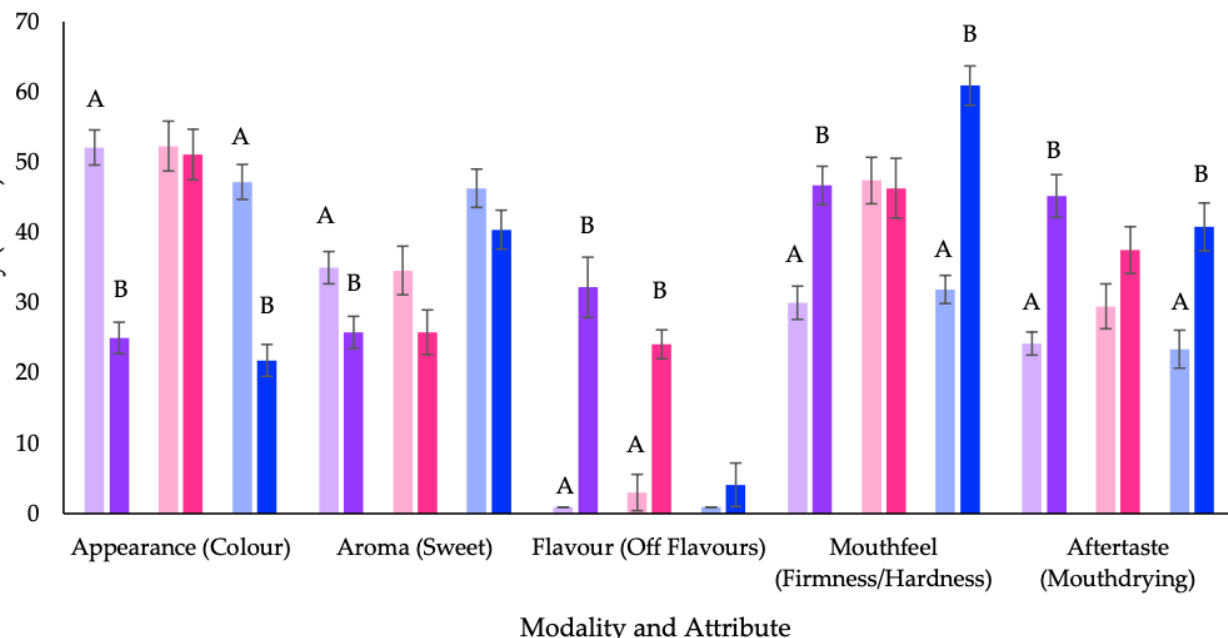
Figure 3. Summary of key sensory profile attributes for each modality and product (measured on a visual analogue scale (VAS), 0–100). Values are expressed as mean ± standard error. Significant differences ( p < 0.05) between control and protein sample pairs are denoted by differing letters; no letter between sample pair reflects no significant difference. Colour (cake/cupcake: darkness of yellow colour of crumb; biscuit: darkness of colour (top)) and firmness refers to cakes/cupcakes and hardness refers to biscuits.